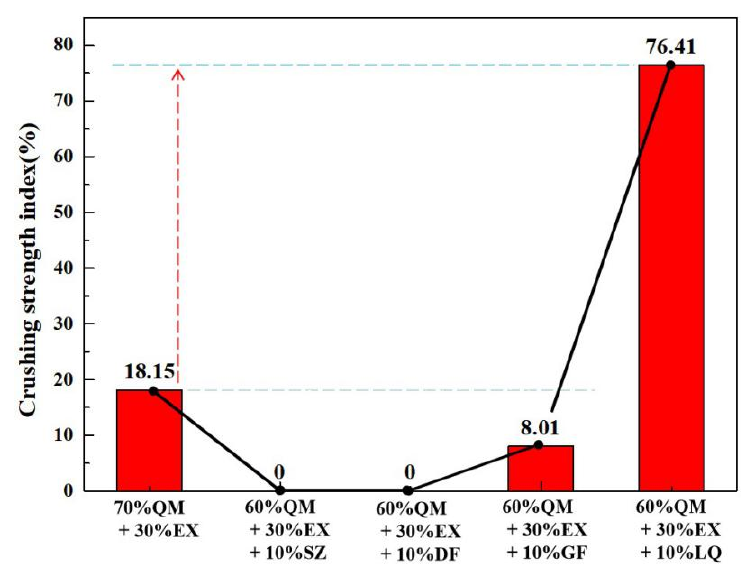
Figure 11. Crushing strength index of ferro-coke with different binders. The porosity of ferro-coke with different binders was analyzed by image J software, which was 60.12% (SZ), 62.63% (DF), 60.24% (GF), and 53.91%(LQ), respectively. It can be found that the porosity of LQ was decreased significantly compared to QE3, while that of other ferro-cokes (SZ, DF, and GF) increased to a certain extent. As shown in Figure 12, the carbon matrix fell off from the cross-section of SZ, DF, and GF (red dotted lines). The orange area in the Figure 12 is the broken part of the ferro-coke matrix, which is filled with the resin material.